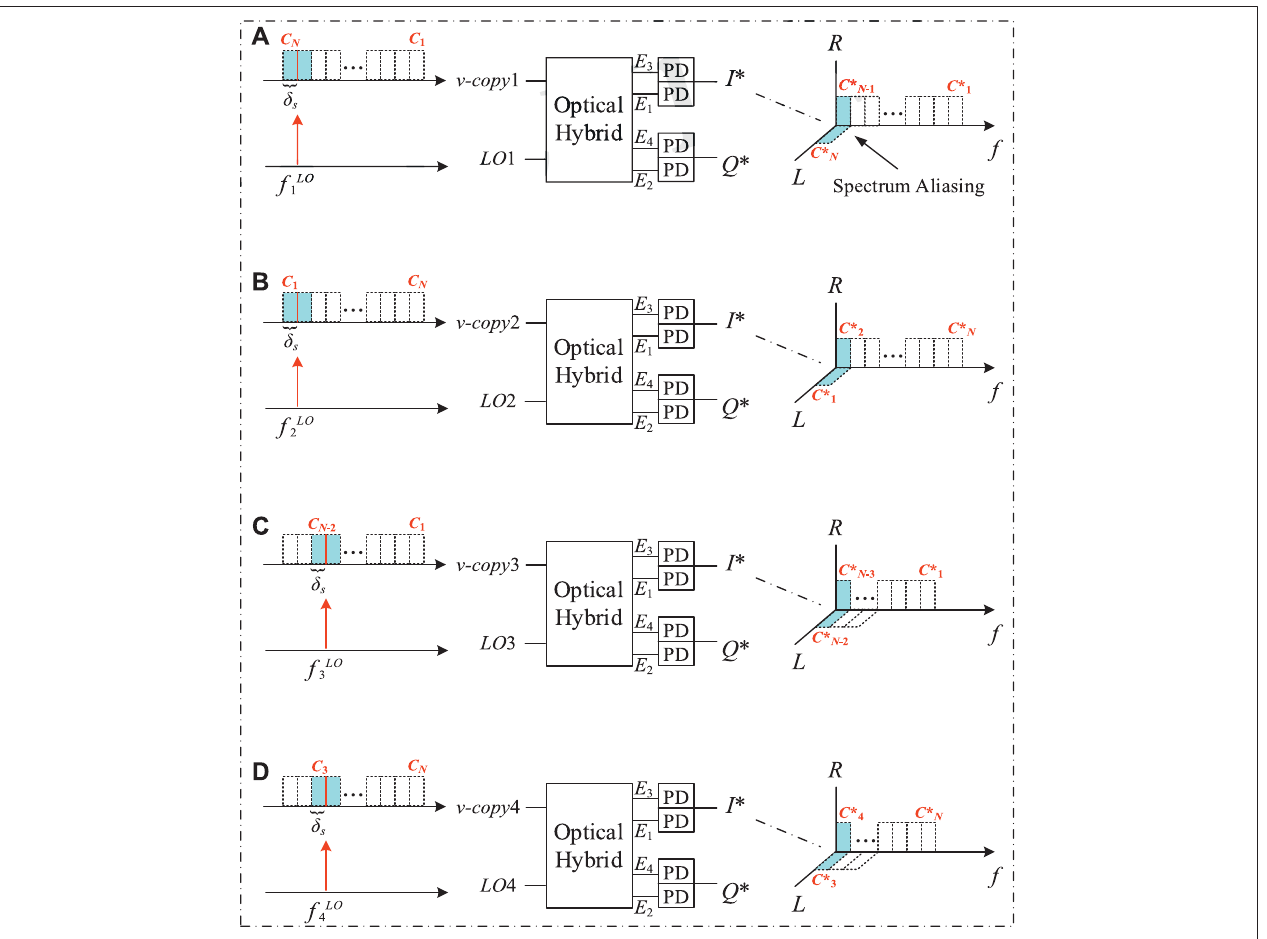
FIGURE 4 | Schematic diagrams of 2 × 4 90 ° optical hybrid reception for the fi rst four v-copies and local oscillators (LOs), where (A – D) show the spectra of the v-copy 1 and the LO 1, the v-copy 2 and the LO 2, the v-copy 3 and the LO 3, as well as the v-copy 4 and the LO 4, and the spectra of them after detecting by photodetectors (PDs),